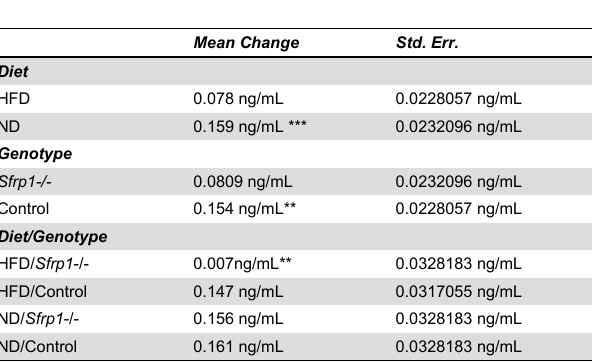
Table 2. Regression-adjusted mean change in insulin secretion from 0-15 minutes.